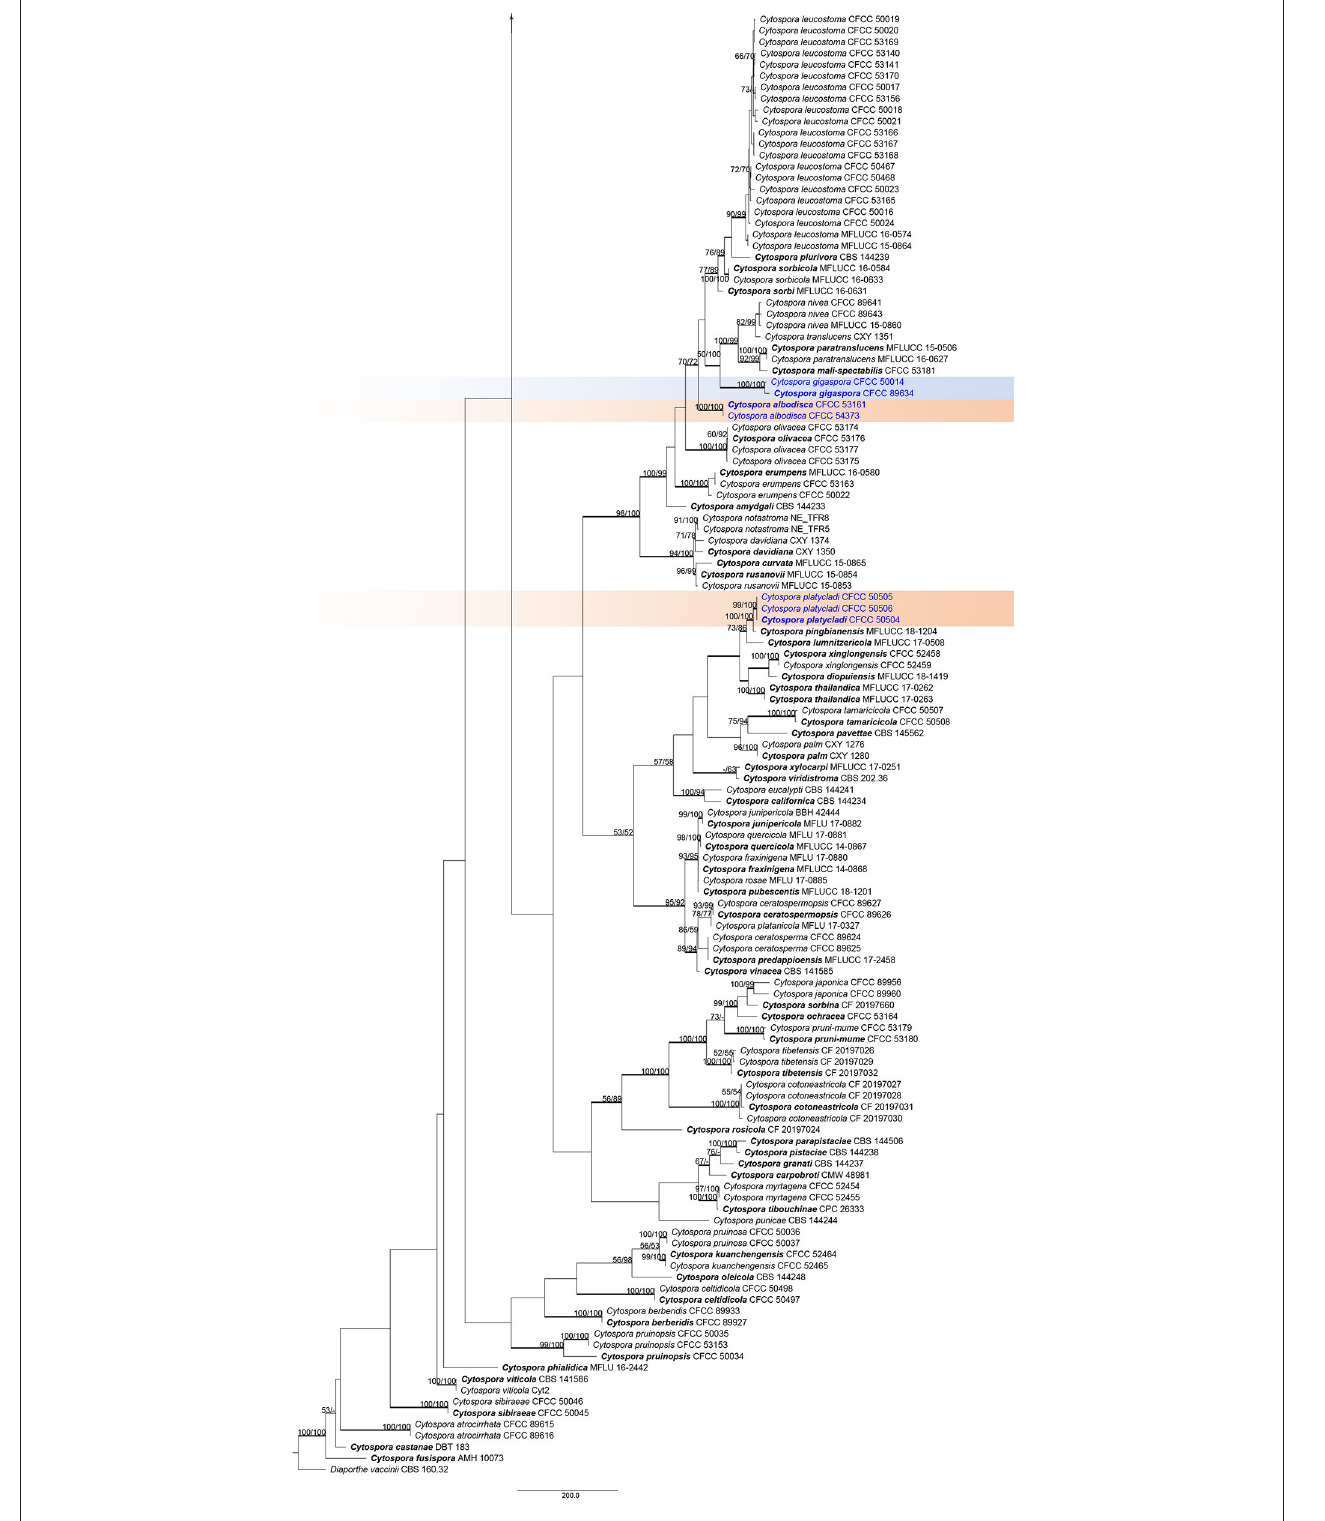
FIGURE 1 | Phylogram of Cytospora based on combined ITS, LSU, act , rpb2 , tef1- α , and tub2 genes. MP and ML bootstrap support values above 50% are shown at the first and second position. Thickened branches represent posterior probabilities above 0.95 from BI. Ex-type strains are in bold. Strains in current study are in blue.